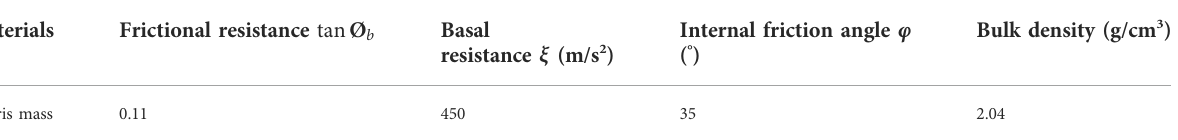
TABLE 3 Physical parameters of